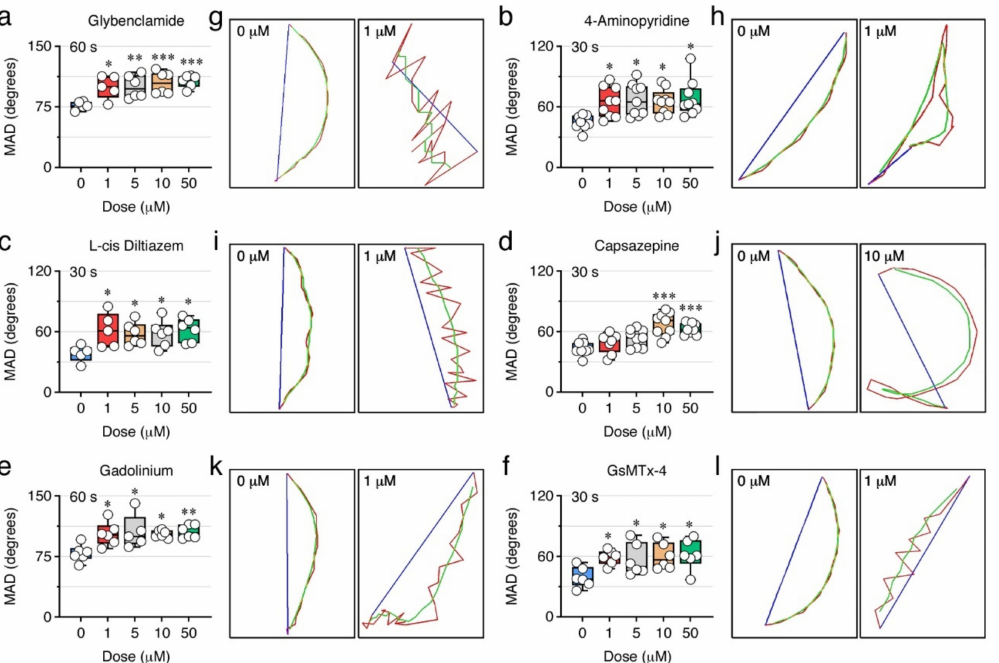
Figure 10. Effect of selected ion channel blockers on the trajectory of seabream spermatozoa. ( a – f ) Absolute mean angular displacement (MAD) of sperm treated with DMSO or the inhibitors at 30 or 60 s post activation in SW. Data points ( n = 6–8 males, one ejaculated per male) are presented as box and whisker plots/scatter dots with horizontal line (inside box) indicating median and outliers. Statistical differences were measured by one-way ANOVA (*, p < 0.05; **, p < 0.01; ***, p < 0.001, with respect to DMSO-treated sperm). ( g – l ) Representative trajectory of a single activated spermatozoon in the presence of DMSO or the different inhibitors analyzed with ISAS ® v1 CASA-Mot system. The red line shows curvilinear velocity (VCL), the blue line shows straight line velocity (VSL), and the green line shows average path velocity (VAP). The complete capture video sequences tracked at 25 frames per second are shown in Supplementary Figure